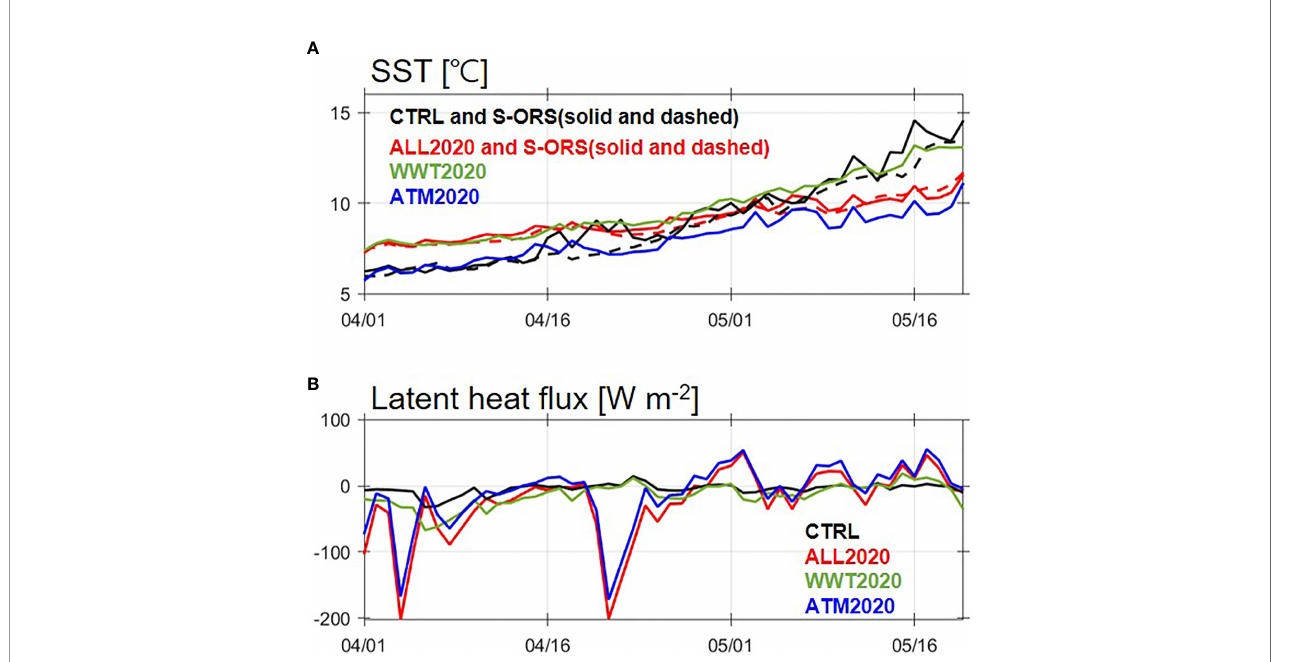
FIGURE 3 | Time series of simulated (A) SST (°C) and (B) latent heat fl ux (W m -2 ) for the CTRL (black line), ALL2020 (red), WWT2020 (green), and ATM2020 (blue) from 1 April to 20 May. The dashed lines denote the observed SST during the period 2017 – 2019 and 2020 from the